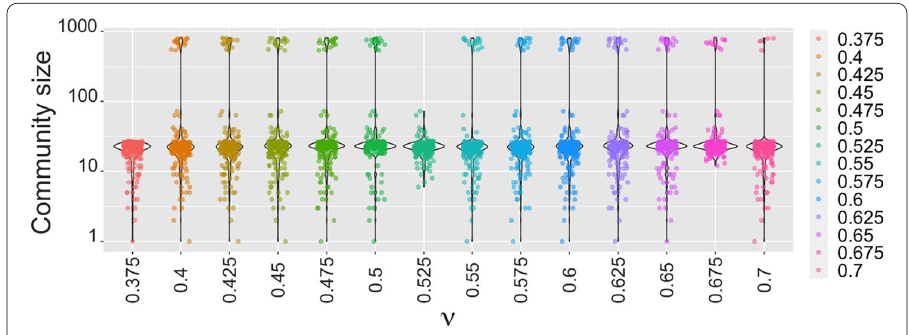
Fig. 6 The community size distribution is shown for a fixed value of ( α = 0.70 ) and varying value of ν ∈ [ 0.375,0.70 ] . The size of network = 1000 , Average degree k = 150 , Maximum degree K max = 200 . The mixing parameter µ = 0.1 , t = 1 , t 2 = 1 . The initial seed node and threshold δ are the same for each value of